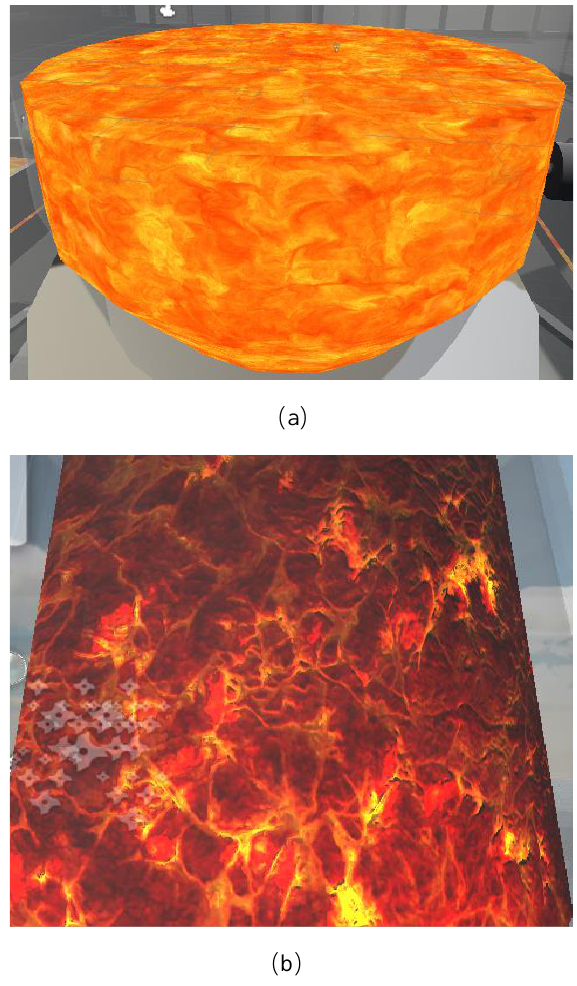
Figure 2. Shaders render renderings of ironmaking blast furnace process. It is a three-dimensional rendering of the whole iron pool and the material layer with high-resolution textures. (a)The rending of the inner ironmaking pool; (b) Three-dimensional dynamic material layer rending effect.